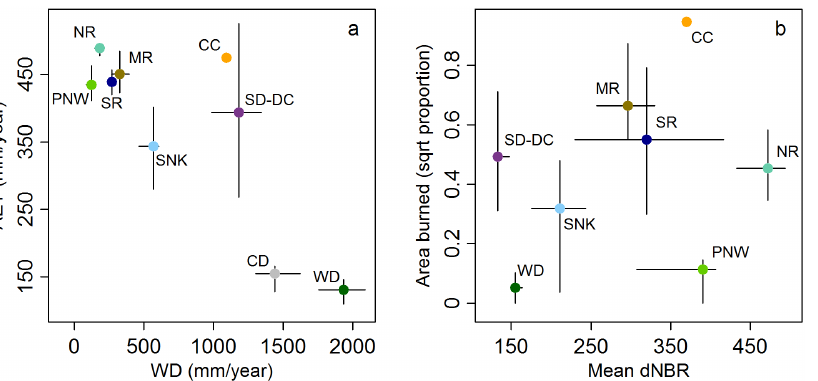
Figure 3. AET and WD averaged across hexels in each ecoregion [48] (a). Area burned and dNBR averaged across hexels in each ecoregion (b). Although the cold desert ecoregion did experience some fire within the hexels we analyzed (see Fig. 2), there were no dNBR data for this ecoregion (see Methods); therefore, this ecoregion is not included in the plot on the right (b). Vertical and horizontal lines represent the middle 50 percent (25 th to 75 th percentile) of the hexel values in each ecoregion.